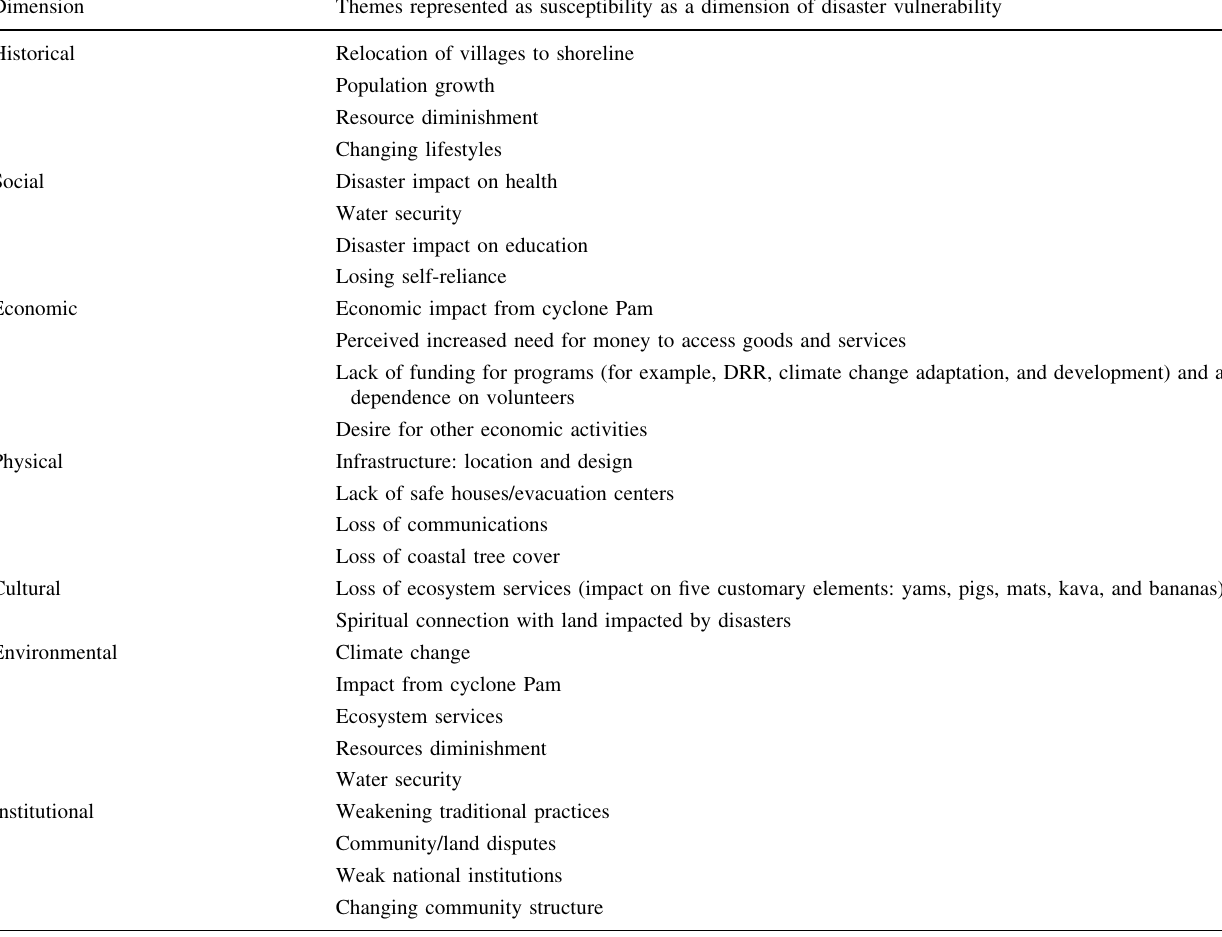
Table 2 Major themes for each susceptibility dimension of disaster vulnerability